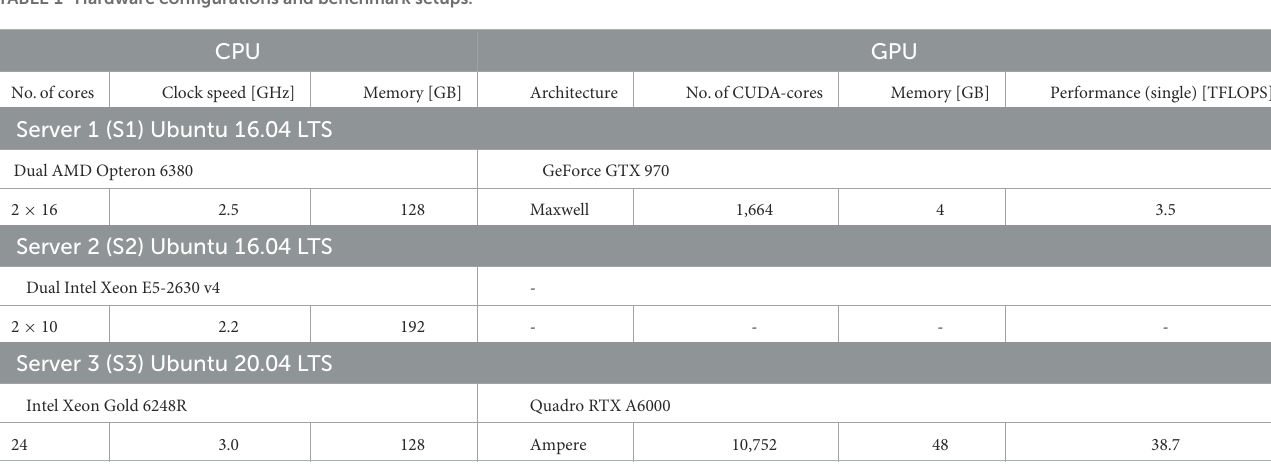
TABLE 1 Hardware configurations and benchmark